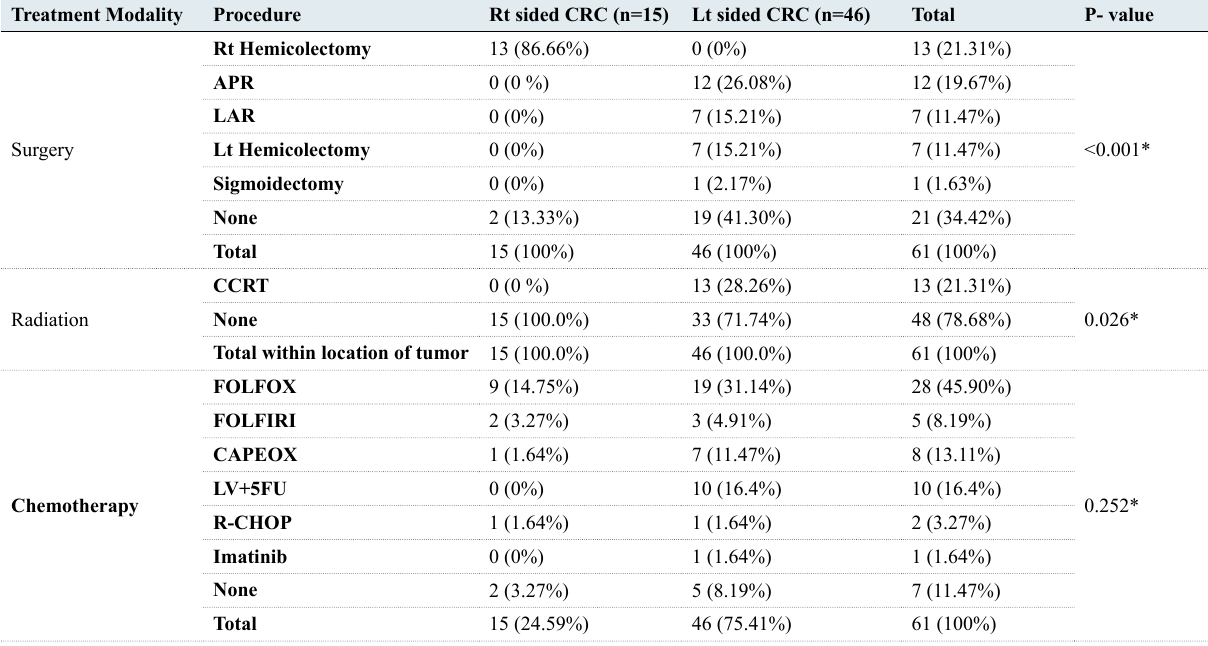
Table 5: Treatment of CRC in AYA among the study population Treatment Modality